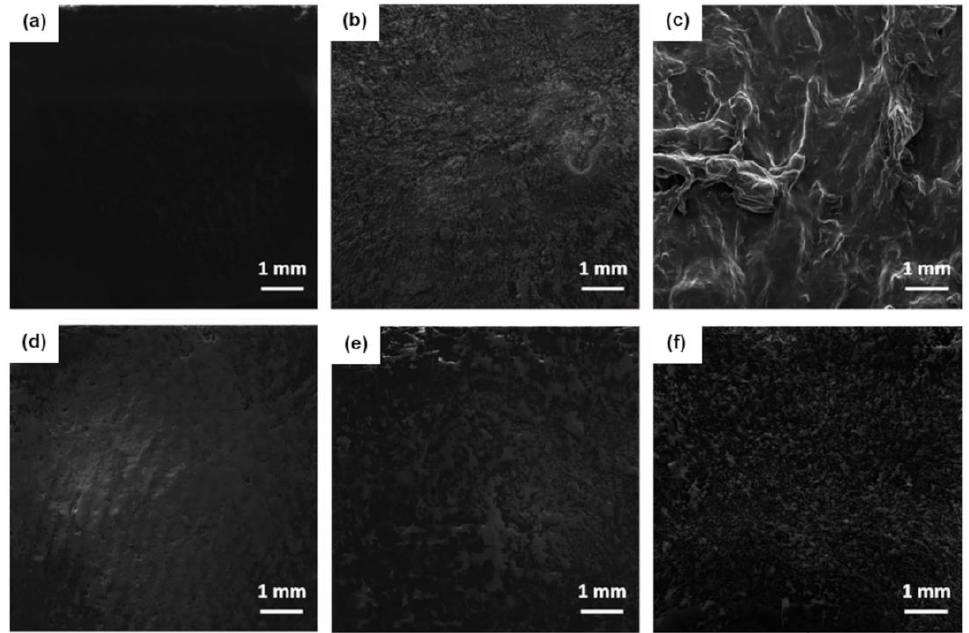
Figure 6. SEM images of ( a ) epoxy/GNP AO-4 1 wt%, ( b ) epoxy/SWCNT 1 wt%, ( c ) epoxy/ SWCNT SWCNT 4 wt%, ( d ) epoxy/GNP 8 SWCNT 2 1 wt%, ( e ) epoxy/GNP 8 SWCNT 2 4 wt% and 4 wt%, ( d ) epoxy/GNP 8 SWCNT 2 1 wt%, ( e ) epoxy/GNP 8 SWCNT 2 4 wt% and ( f ) ( f ) epoxy/GNP 8 SWCNT 2 5 wt% nanocomposite samples (top surface) after epoxy/GNP 8 SWCNT 2 5 wt% nanocomposite samples (top surface) after cure.